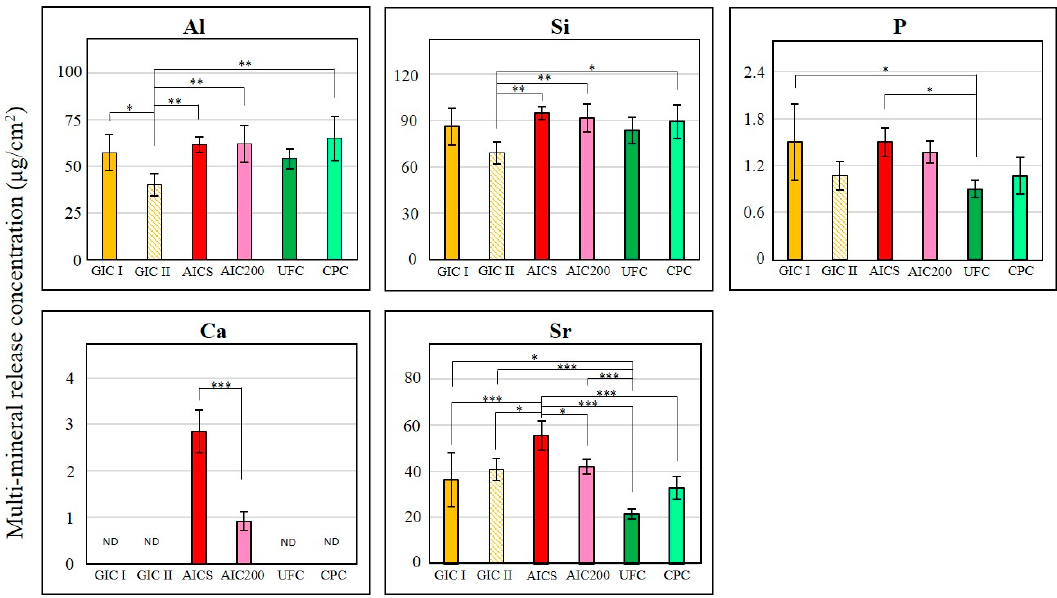
Figure 4. After immersed in deionized water at 37 °C for five days, the quantities of Al, Si, P, Ca and Sr generated during Experiment II per unit sample surface area ( n = 5/group). ND: not detected. (* p < 0.05; ** p < 0.01; *** p < 0.001).